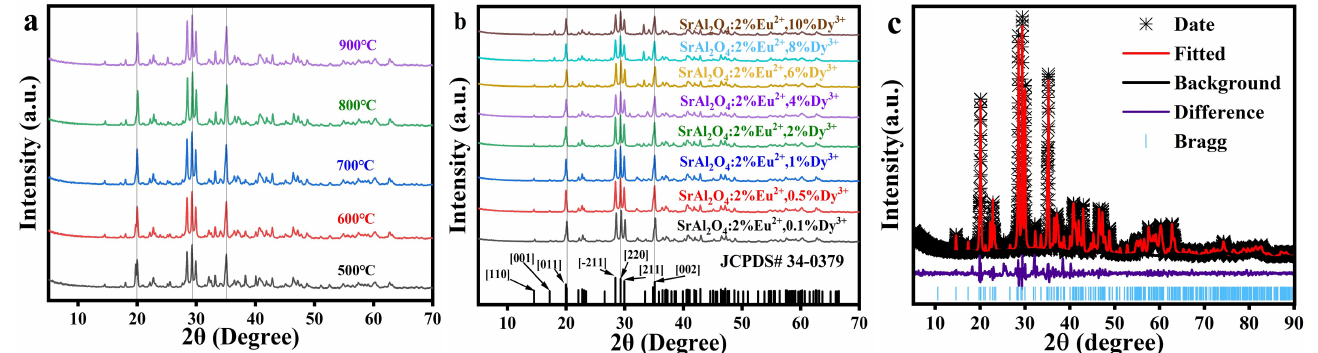
Figure 1. ( a ) X-ray diffraction (XRD) investigation based on the samples prepared at different temperatures, ( b ) XRD investigation based on the samples prepared at different Dy ion doping concentration, ( c ) The XRD refinement of SrAl 2 O 4